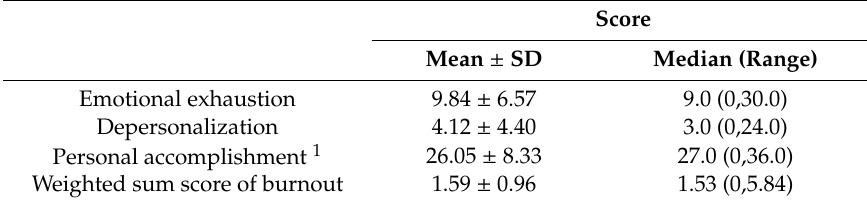
Table 3. Scores in each dimension and the weighted sum score of job